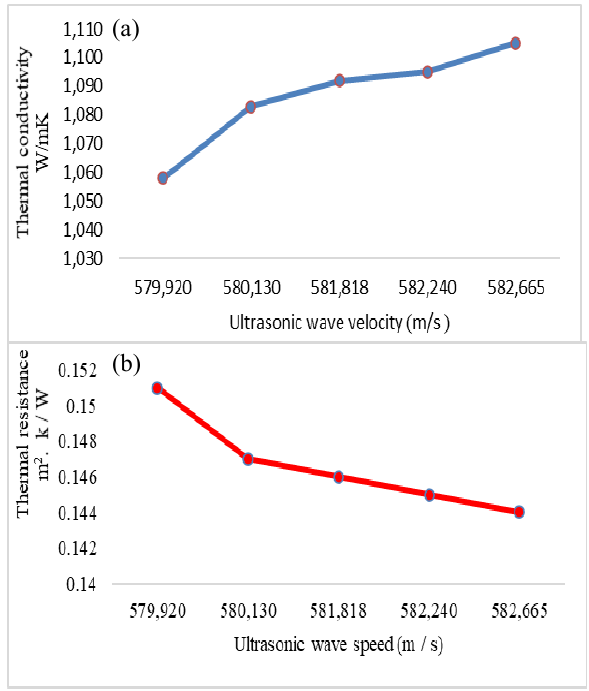
Figure 5. The variation :(a) Thermal